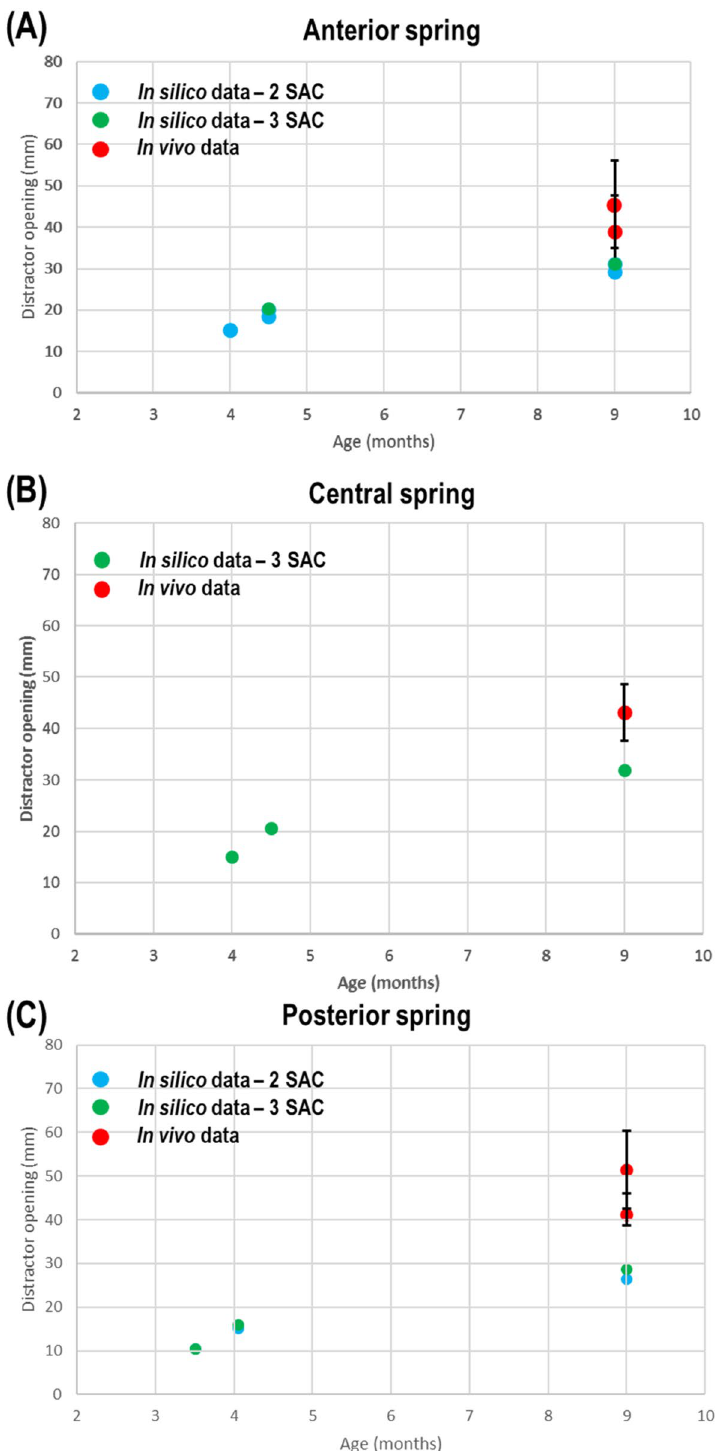
Figure 3. Predicted vs. in vivo spring opening data with SD. Showing anterior ( A ), central ( B ) & posterior ( C ) springs in both SAC techniques. Diagrams show regions where measurements were